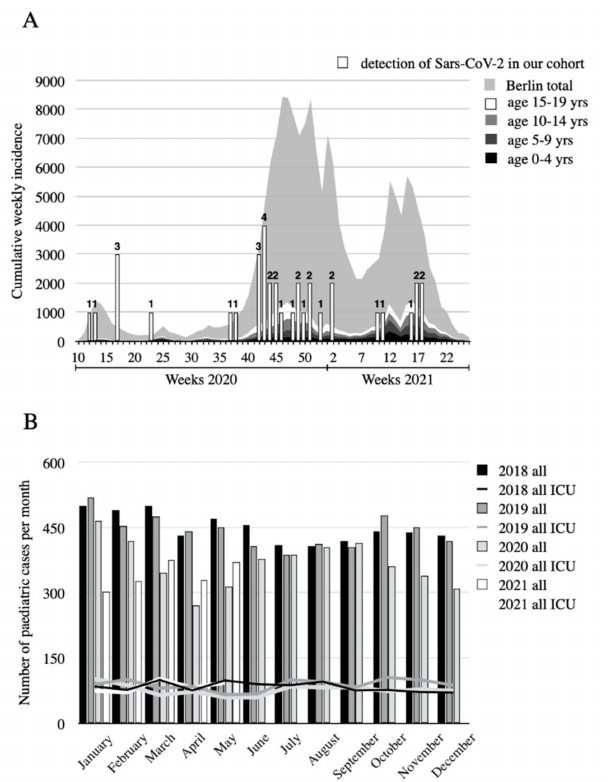
Figure 2. Assortment of positive SARS-CoV-2 tests in our cohort with the overall dynamic of the pandemic ( A ) and compilation of pediatric case numbers and intensive care unit (ICU) cases 2018–2021 ( B ). Local SARS-CoV-2 incidence per calendar week at our study site and area served in Berlin, Germany was obtained from Robert-Koch-Institute (grey graph, age groups 0–19 years in different greyscale as indicated) and plotted together with positive SARS-CoV-2 tests in our cohort 1 (white bars, scale is 1/1000 of x -axis, the actual number of positive tests is given above) ( A ). Total monthly number of pediatric hospital admissions is shown in the bar graph, the number of children admitted to ICU indicated with lines (black: 2018, grey: 2019; light grey: 2020; white: 2021) ( B